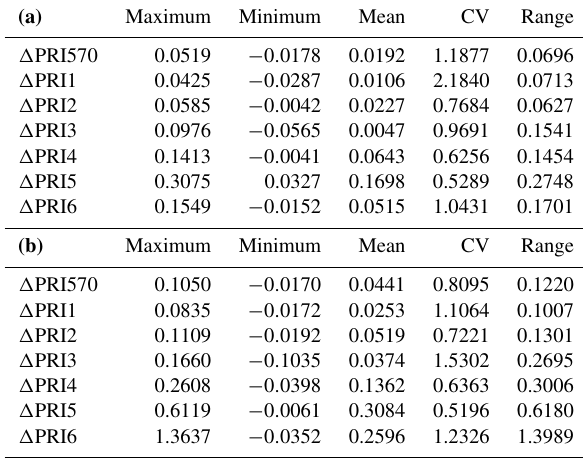
Table 2. The maximum, minimum, mean, CV and range of the dif- ference ( (cid:49) PRI) between PRI of sunlit leaves and PRI of shaded leaves for the control treatment ( a ) and the water stress treat- ment ( b ).